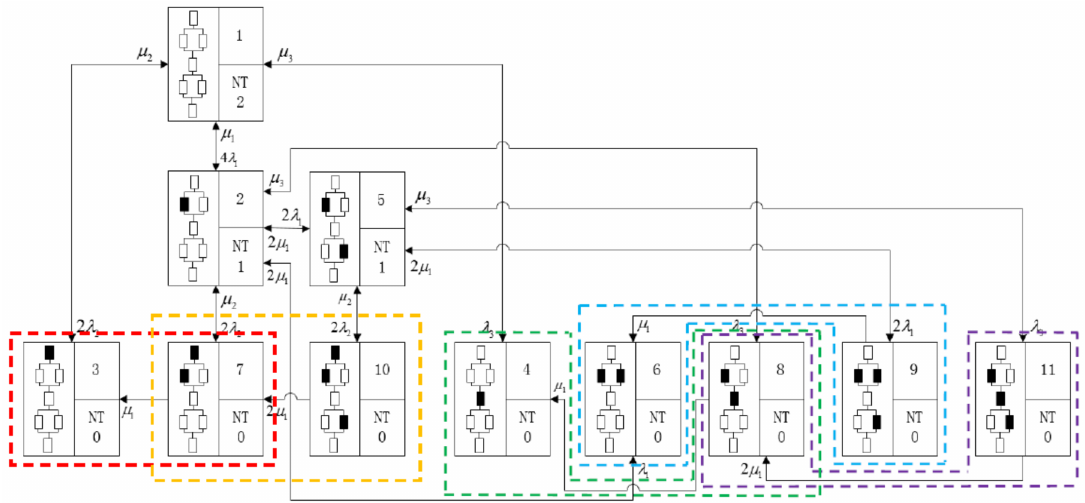
Figure 4. Monopole state space model of UHVDC transmission